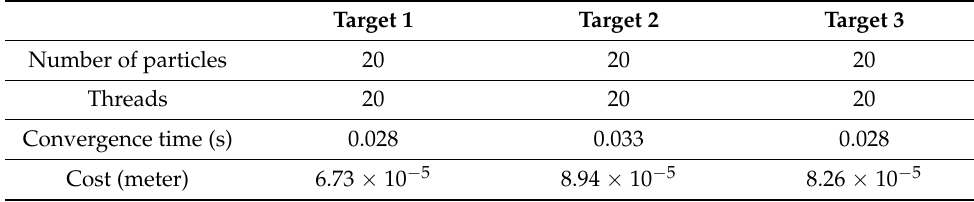
Table 3. One particle per thread.